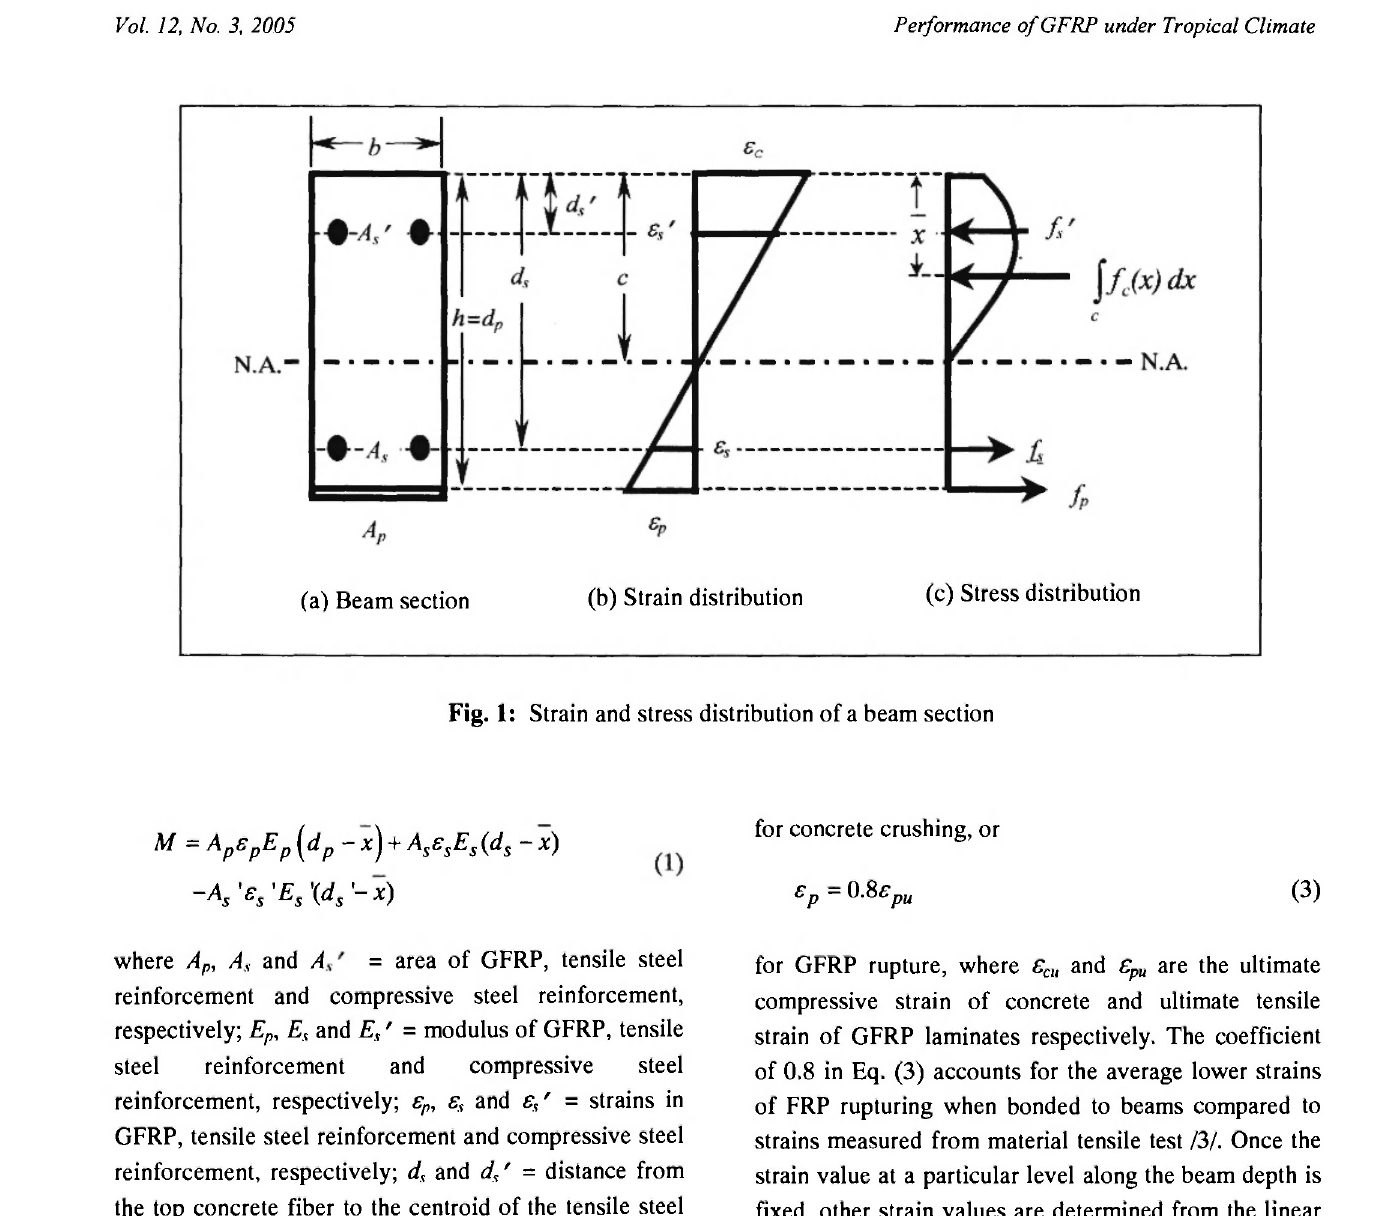
Fig. 1: Strain and stress distribution of a beam